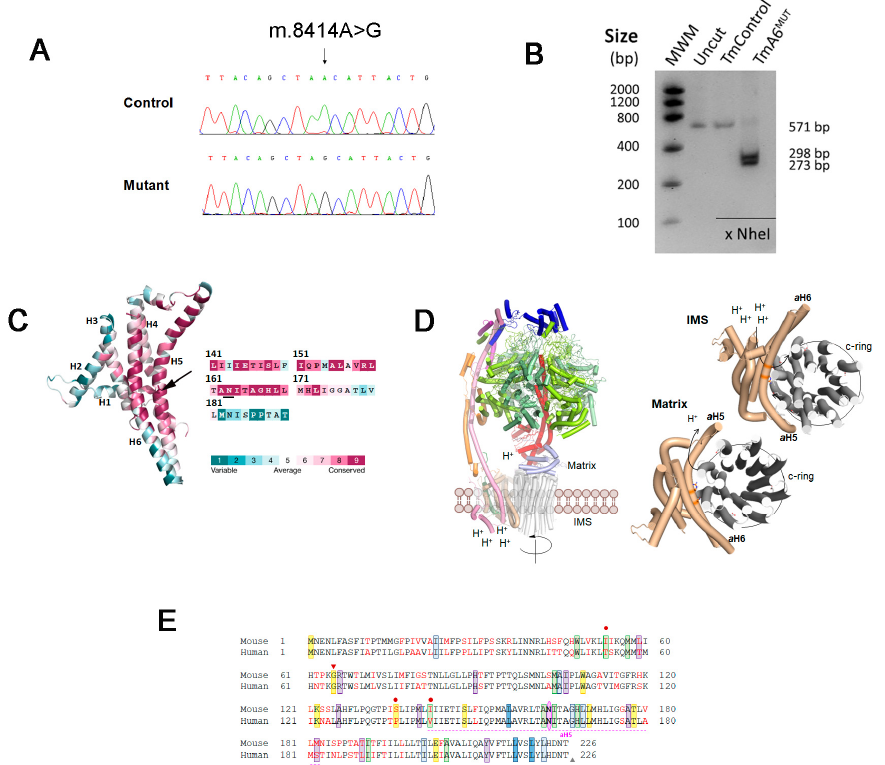
Figure 1. Analysis of m.8414A>G mutation in mt-Atp6 gene and protein: ( A ) chromatogram showing the m.8414A>G mutation within the mt-Atp6 gene in mutant BcTMP11.1 cells; ( B ) RFLP analysis of the mutation in transmitochondrial mutant (TmA6 MUT ) and control (TmControl) cells. The presence of the mutation creates a recognition site for NheI; ( C ) ConSurf analysis of F o F 1 ATP synthase subunit a (MT-ATP6) from Mus musculus shown as cartoon colored according to the conservation score calculated by ConSurf server (left). The protein is folded in six transmembrane α -helixes connected by loops. The N163 (represented with sticks, black arrow) is an exposed residue located in a highly conserved region of helix aH5. As shown in the aH5 sequence (right), N163 is a highly conserved amino acid; ( D ) structure of mitochondrial ATP synthase (left) and interaction of subunit a with the c-ring (right). Left: Cartoon representation of subunit composition of the bovine ATP synthase monomer (PDB 6zpo). The catalytic subunits α and β (upper part) are lemon yellow and pale green, respectively. The asymmetrical central stalk subunits ƴ , δ and ɛ are red, light blue and violet, respectively. The peripheral stalk subunits OSCP, F6, b and d are blue, violet, pink and orange, respectively. The membrane domain composed of the c-ring in contact with subunit a, and the supernumerary subunit A6L are gray, wheat and green forest, respectively. To simplify the representation, the rest of supernumerary subunits e, f, g, j and k have been omitted. Right: View of the entire c-ring and subunit a from the intermembrane space and matrix (upper and bottom panels, respectively) and the path of protons, showing subunit a and c-ring (PDB 6zpo). The side chains of the essential residues for proton transfer, E59 and R159 (c-ring and subunit a, respectively), and the mutated N163 residue are shown as CPK colored sticks with C atoms in grey for c-ring, and in wheat for the subunit a; and ( E ) alignment of human and murine MT-ATP6 protein sequences. Reported human pathological mutations and the mouse mutation (pink) are highlighted in the sequence with the following color code: green for LOHN causing mutations, blue for NARP, MILS or Leigh syndromes (dark blue: frequent mutations; light blue: rare mutations), purple for autism or schizophrenia-related mutations and yellow for “other mutations”. Triangles indicate mutations creating a stop codon (red: insertion; grey: deletion). Red dots indicate the presence of mutations in the human protein that introduce an amino acid change identical to that of the murine